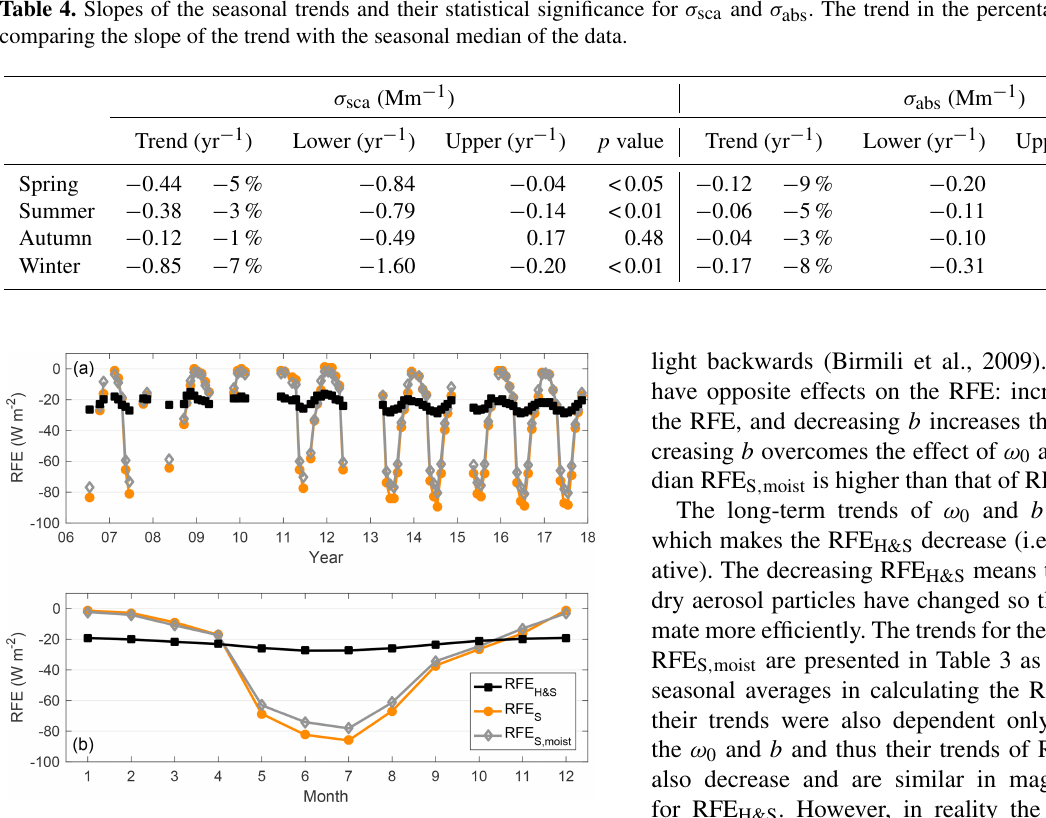
Figure 6. Variations in the different radiative forcing efficiencies at SMEAR II in 2006–2018. (a) Time series of the RFE H&S , RFE S , and RFE S , moist . The monthly medians are presented if the month had at least 14d of valid data. (b) Seasonal variation in the RFE H&S , RFE S , and RFE S , moist as overall monthly medians. RFE was calcu- lated for PM 10